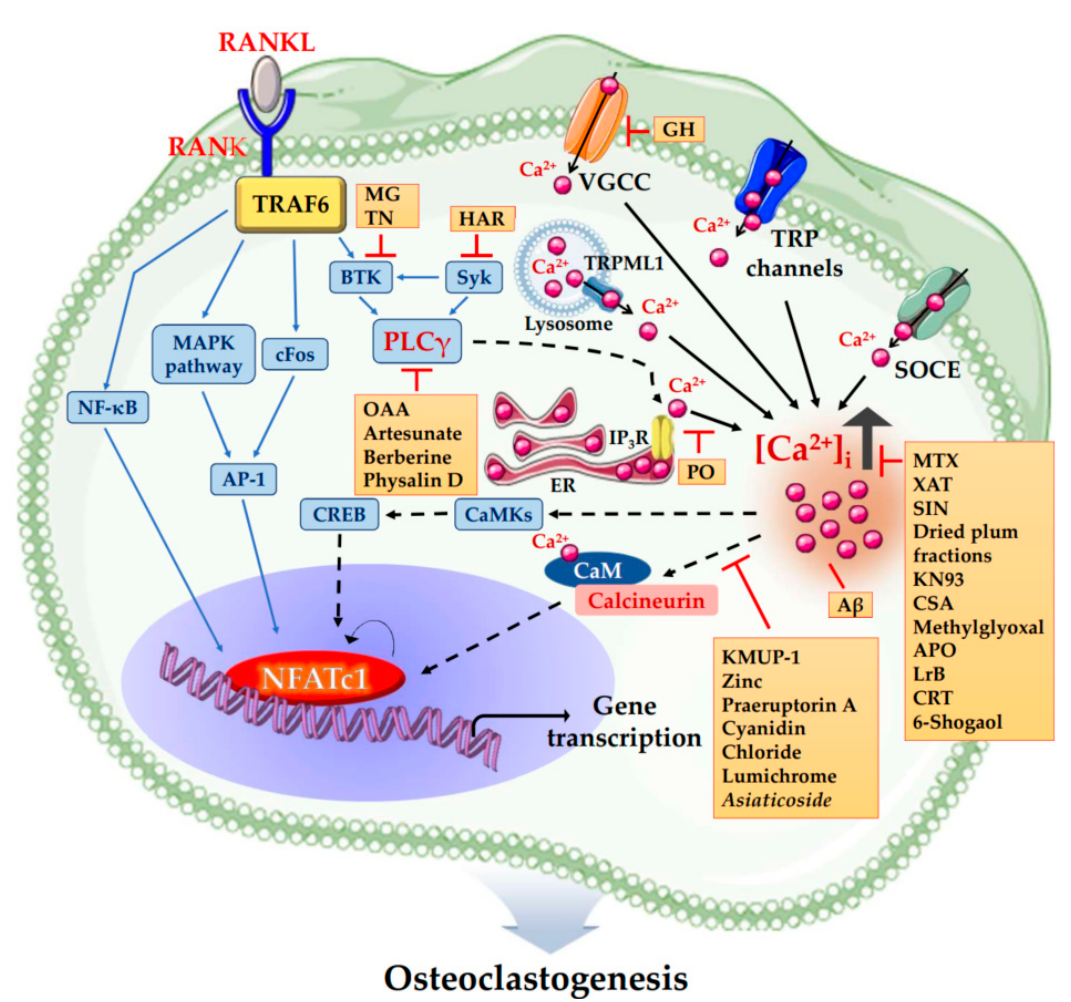
Figure 2. The schematic illustration summarized diverse compounds that regulate Ca 2 + signaling in osteoclastogenesis. KMUP-1 (7-[2-[4-(2-chlorophenyl)piperazinyl]ethyl]-1,3-dimethylxanthine), Zinc, Praeruptorin A, Cyanidin Chloride, Lumichrome and Asiaticoside inhibit osteoclastogenesis via inhibiting Ca 2 + -Calcineurin-NFATc1 signaling independent of PLC γ . Methotrexate (MTX), Xanthotoxin (XAT), Sinomenine (SIN), Dried plum fractions, KN93, Cajaninstilbene acid (CSA), Methylglyoxal, Apocynin (APO), Loureirin B (LrB), Calreticulin (CRT) and 6-Shogaol inhibit osteoclastogenesis via decreasing [Ca 2 + ] i . On the contrary, Amyloid beta peptide (A β ) enhances osteoclastic bone resorption by increasing [Ca 2 + ] i oscillations, resulting in upregulation of NFATc1. Portulaca oleracea (PO) inhibits osteoclastogenesis by inhibiting Ca 2 + release from intracellular Ca 2 + stores. Oleanolic acid acetate (OAA), Artesunate, Berberine and Physalin D inhibit osteoclastogenesis via inhibiting PLC γ -Ca 2 + -NFATc1 signaling. Harpagoside (HAR) inhibits osteoclastogenesis via inhibiting Syk-Btk-PLC γ -Ca 2 + Signaling. Methyl gallate (MG) and Tatarinan N (TN) inhibit osteoclastogenesis by suppression of Btk-PLC γ cascade. Glechoma hederacea (GH) inhibits osteoclastogenesis by inactivating VGCCs independent of Ca 2 + release from intracellular Ca 2 + stores. Abbreviations: RANKL, receptor activator of nuclear factor- κ B (NF- κ B) ligand; RANK, receptor activator of nuclear factor- κ B (NF- κ B); NFATc1, nuclear factor of activated T cells cytoplasmic 1; TRAF6, tumor necrosis factor (TNF) receptor-associated factor 6; MAPK, mitogen-activated protein kinases; AP-1, activator protein-1; Btk, Bruton’s tyrosine kinase; Syk, spleen tyrosine kinase; PLC γ , phospholipase C γ ; IP3R, inositol 1,4,5-triphosphate receptor; ER, endoplasmic reticulum; Ca 2 + , calcium; [Ca 2 + ] i, intracellular Ca 2 + concentration; SOCE, store-operated Ca 2 + entry; VGCC, voltage-gated Ca 2 + channel; TRP channels, transient receptor potential cation channels; CaMKs, Ca 2 + / calmodulin dependent protein kinases; CREB, cAMP-responsive element-binding protein; CaM,